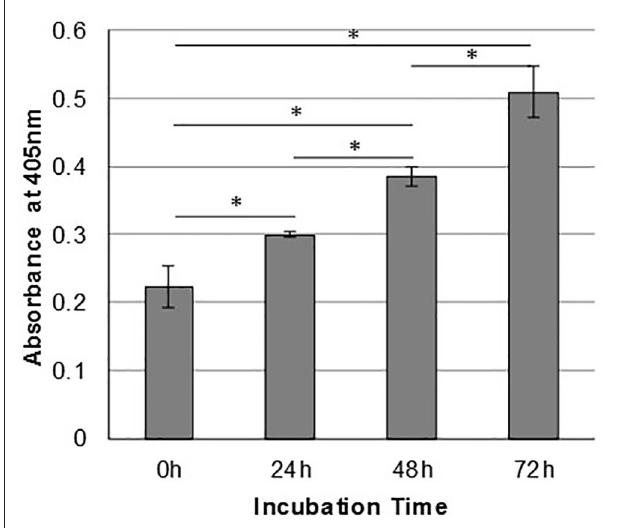
FIGURE 2 | Mesothelioma cells shed gC1qR into the extracellular milieu. MSTO-211H cells were cultured in complete medium, and supernatants were sampled at 24-h intervals. Relative concentrations of gC1qR in the supernatants at each time point were determined via a direct ELISA. Error bars represent mean substrate absorbance ± standard deviation. n = 2 separate experiments performed in duplicate. *Significantly different results at p < 0.05.